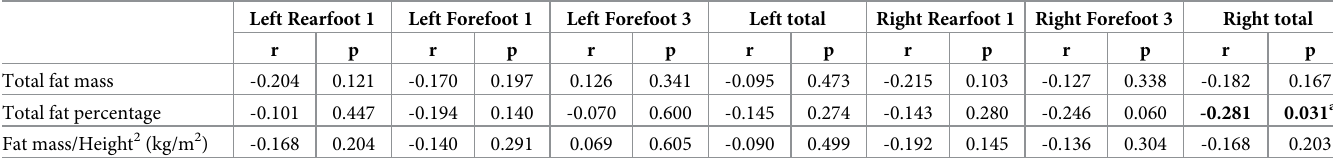
Table 3. Relationship between FPI-6 scores and DXA outcomes in children with